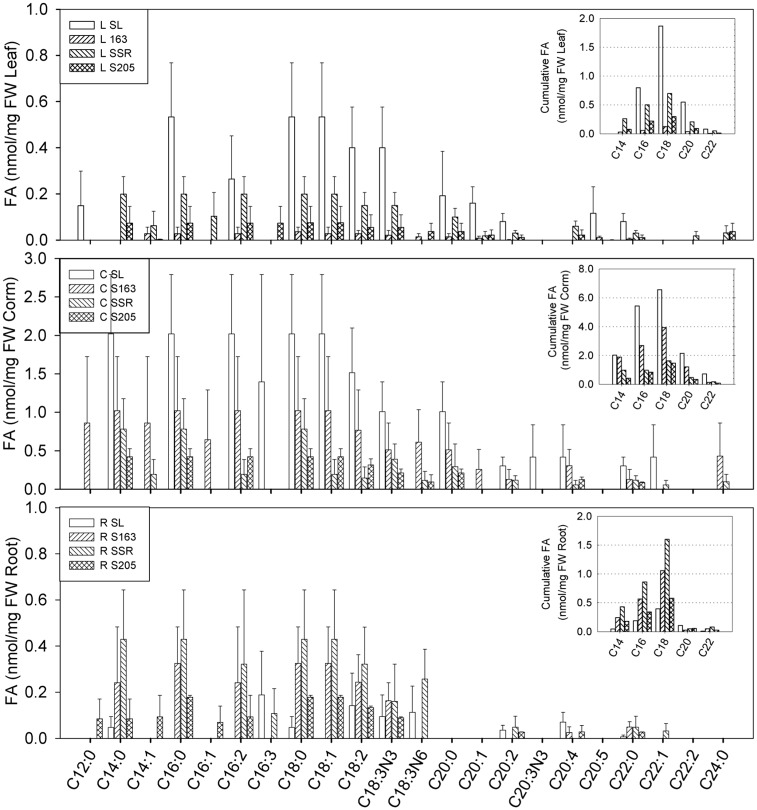
Fatty acid content and distribution in vegetative organs of Cyperus laxus.Fatty acid content and fatty acid cumulative chain length distribution (insets) in lipid extracts from leaf, corm, and roots of Cyperus laxus plants from the phytoremediation systems of soil from oil spill-impacted sites containing 16 g/Kg (S163), 140 g/Kg (SSR), and 340 g/Kg (S205) of hydrocarbons compared to control plants cultivated in soil from an unimpacted site (SL). Error bars represent the SDS from at least three plants.